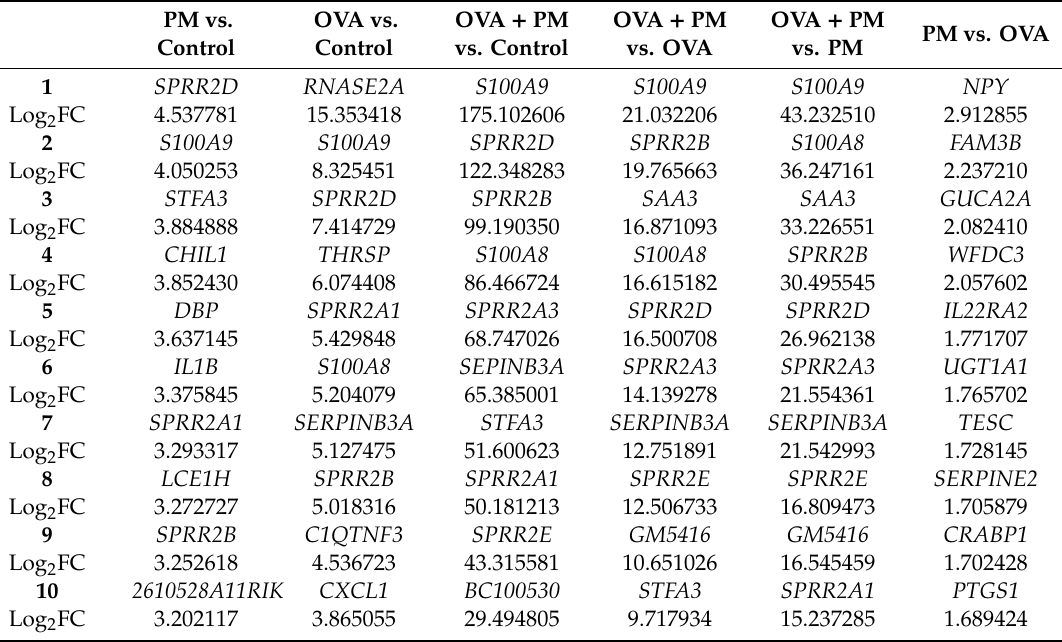
Table 1. Top 10 significantly upregulated genes.